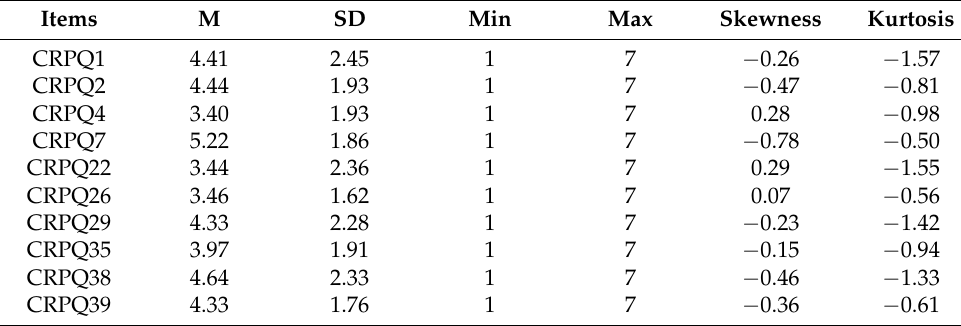
Table 4. Descriptive statistics for items of the CRPQ (Sample